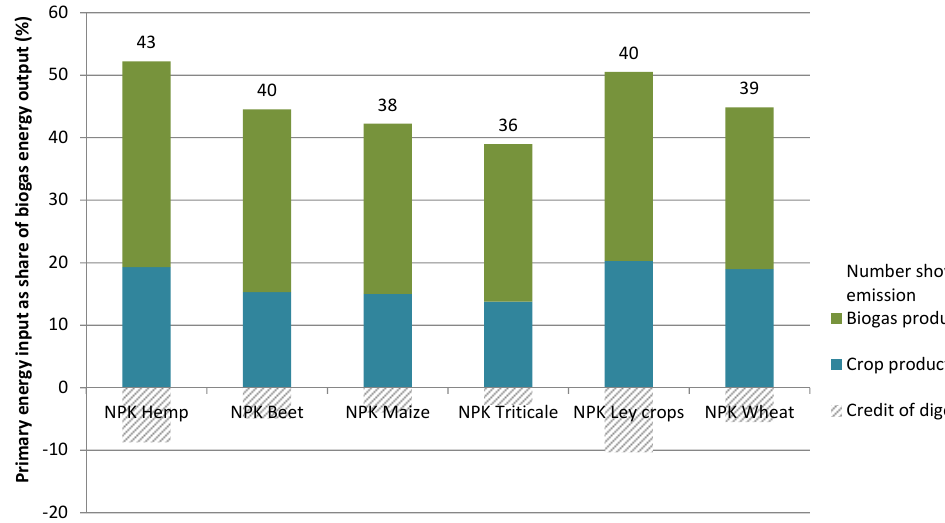
Figure 2. Primary energy input in the crop and biogas production step as a proportion (%) of the biogas energy output for the cultivation systems including only mineral fertiliser (NPK). The credit of digestate is shown as negative bars and the numbers above the bars show the net energy input including this credit. Based on Tables 1, 3 and